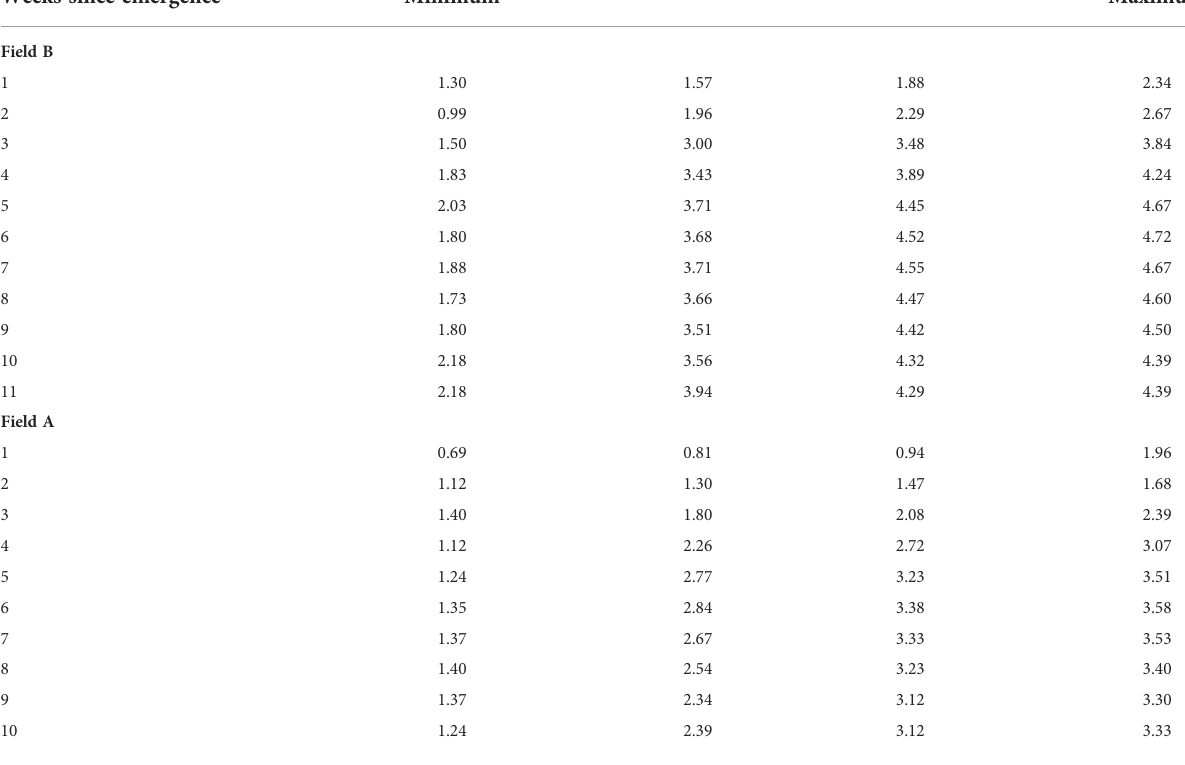
TABLE 3 Evapotranspiration depth (centimeters) for every k-means clustering zone, sorted by minimum depth to maximum depth. Weeks since emergence